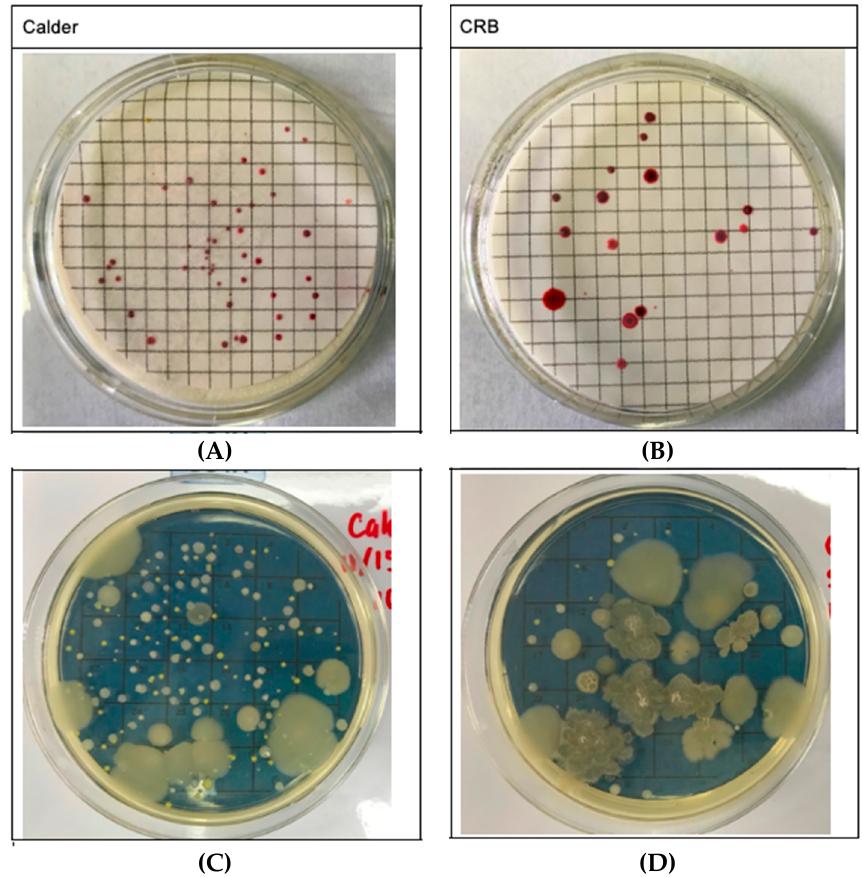
Figure 1. Microbial growth of air samples collected on the sterile gridded cellulose nitrate membrane filter and cultured using the general-purpose nutrient media purchased from MilliporeSigma™ MHA00P2TT ( A , B ). Soya Agar plate placed in a bioaerosol impactor ( C , D ). Both samples in each building were collected simultaneously ( A , C in Calder) and ( B , D in CRB) at a flow rate of 28.5 L/m and incubated for 48 h at 5% CO 2 and 37.5 °C. Number of airborne microbial colonies/m 3 was quantified by counting colonies on soya plates ( C , D ). Note that color differences between colonies qualitatively highlight that different species of microbes (bacterial and fungal) are present in the samples. Table 2. Indoor environmental metrics inside Calder Library and CRB.